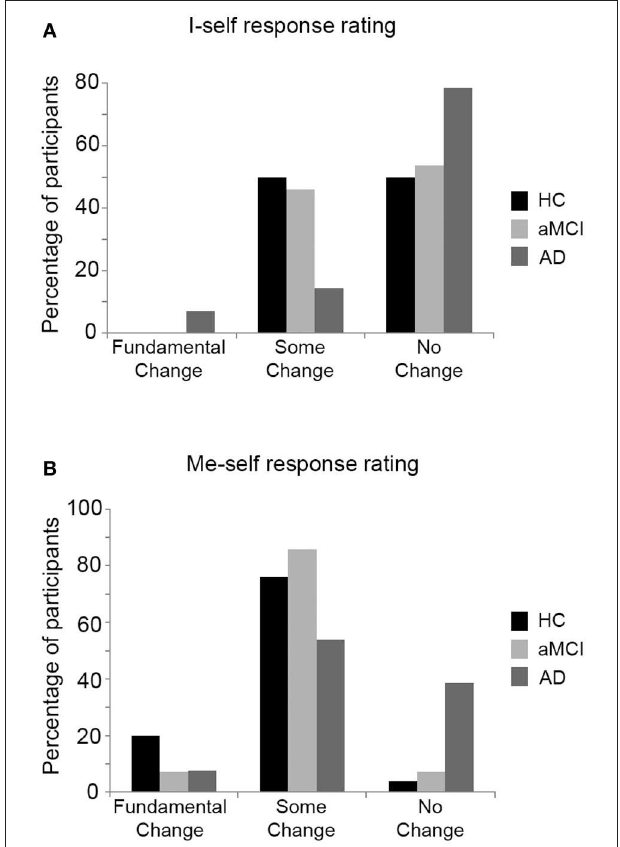
FIGURE 2 | Percentage of participants from each group providing each response type on (A) the I-self rating scale, and (B) the Me-self rating scale of the self persistence interview. HC, Healthy control; aMCI, amnestic Mild Cognitive Impairment; AD, Alzheimer’s